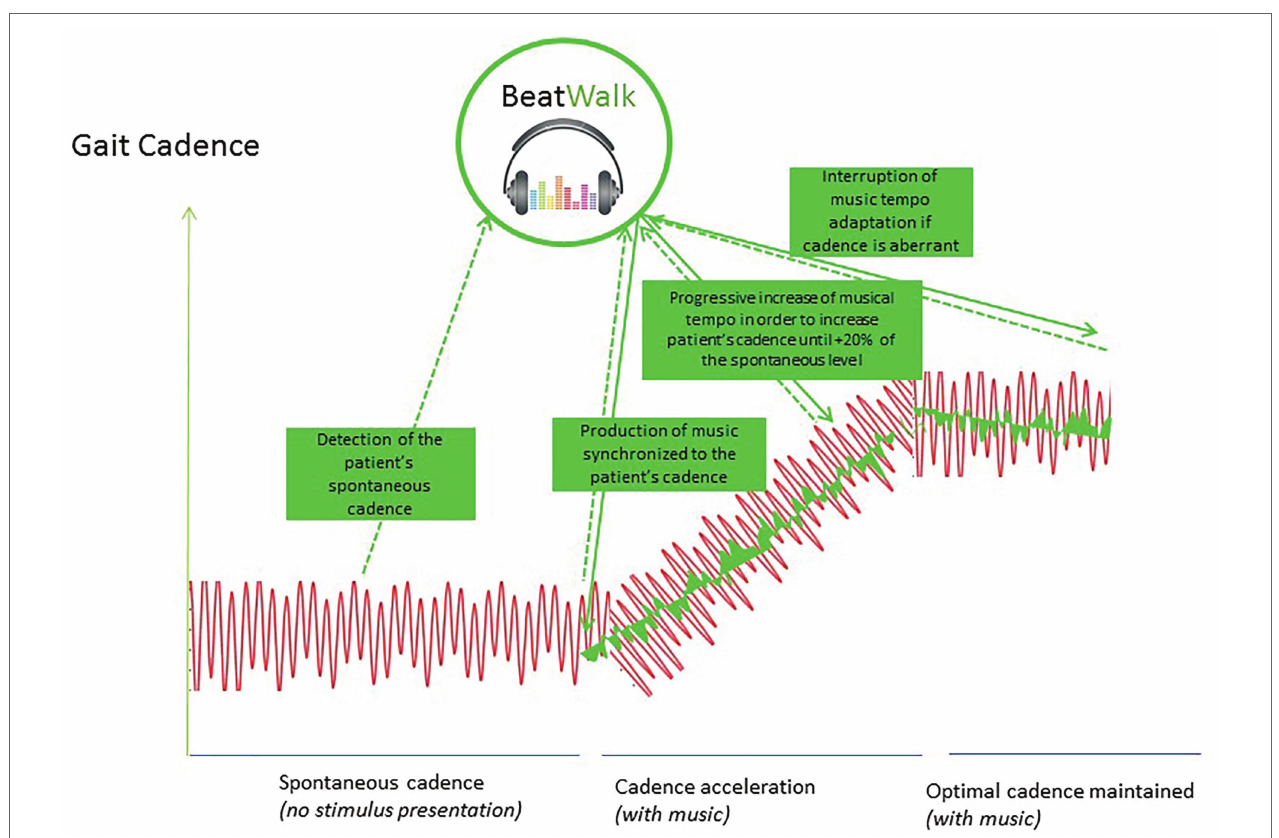
FIGURE 1 | BeatWalk operation: (1) first BeatWalk is silent and detects the patient’s spontaneous gait cadence and phase, (2) BeatWalk generates music with a tempo synchronized to the patient’s spontaneous cadence, (3) BeatWalk modifies subliminally the tempo of the music (changing the peace of music if necessary), to increase it progressively at maximum +20% of the patients spontaneous cadence, (4) BeatWalk maintains the tempo of the music in the targeted cadence